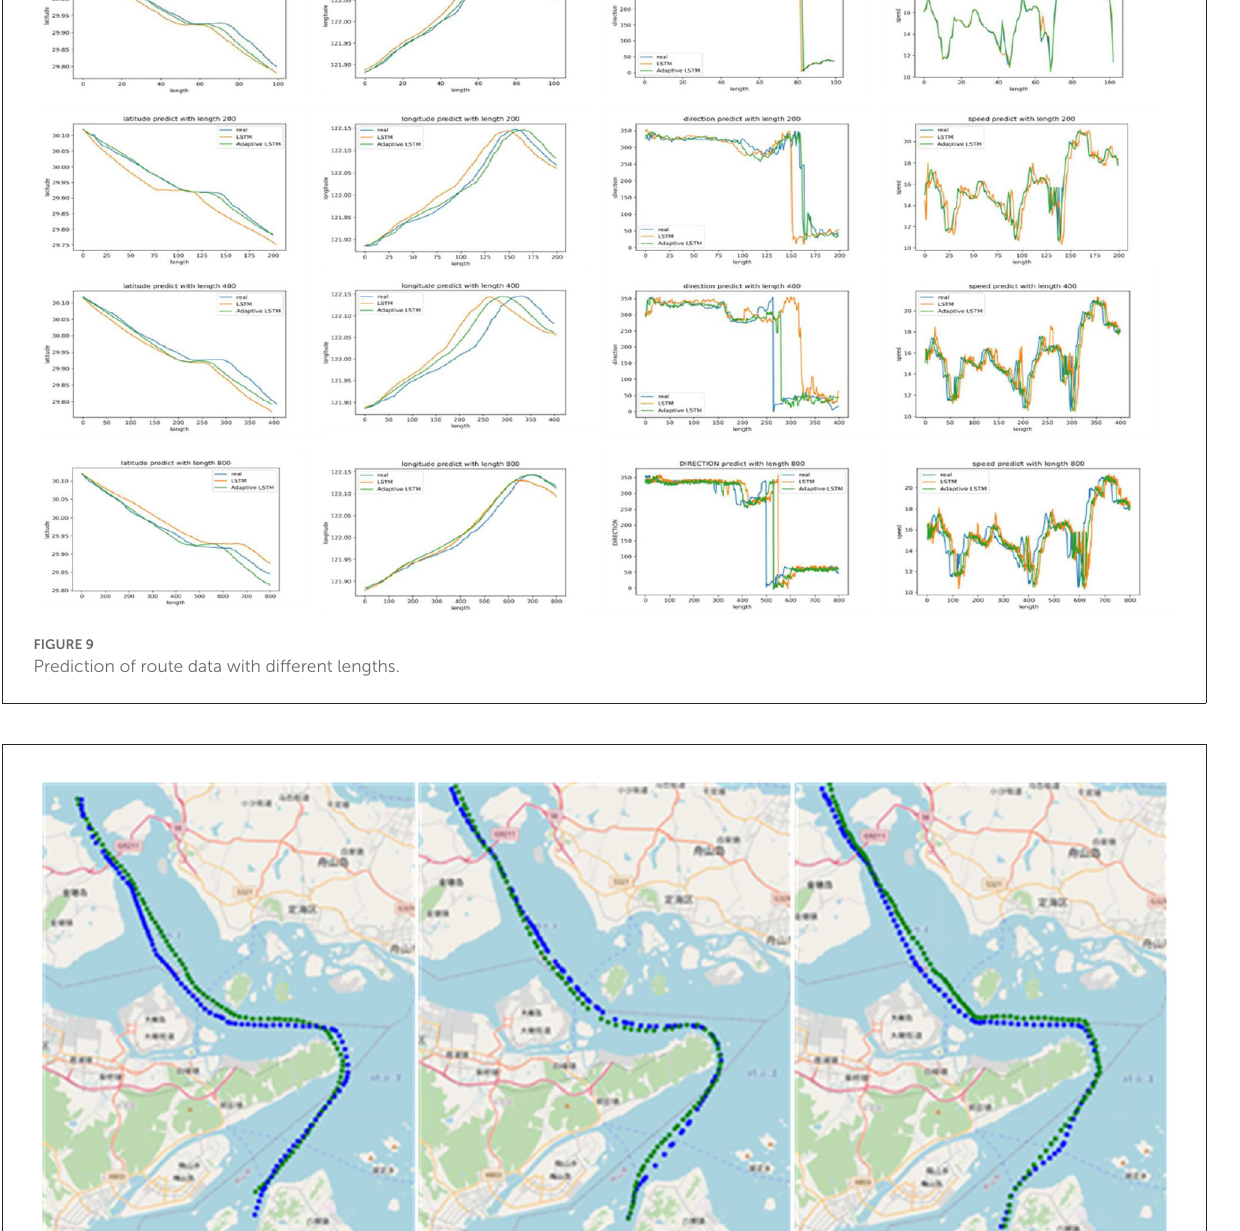
than the improved LSTM, indicating that the improved LSTM prediction decreases faster when the length of the trajectory grows. The error of COG and SOG is larger than that of latitude and longitude. After analysis, it is believed that the prediction range of COG and SOG is larger, resulting in a higher loss